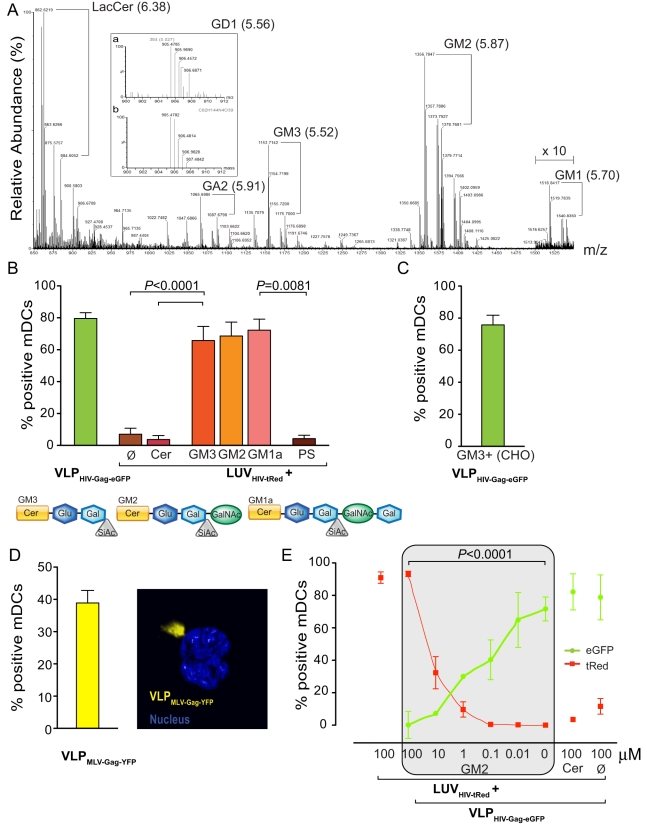
Gangliosides are required for viral capture mediated by mDC.(A) Ganglioside detection in lipid extracts from MT4 derived HIVNL4-3.Partial mass spectrum (from 850 to 1550 amu) corresponding to the 5.3- and 6.5-min range of a UPLC/TOF ESI (+) chromatogram representative of three different viral isolations. The selected time range corresponds to the N-hexadecanoyl (N-C16) species. The N-C22, N-C24, and N-C24:1 species were also observed. For each compound of interest identified, the exact mass of its [M+H]+ and [M+Na]+ ions are indicated. The retention time of each compound is given within parenthesis next to its abbreviation. Inset: exact mass ion cluster obtained at 5.56 min for GD1 (a) and exact mass ion cluster corresponding to the formula C82H144N4O39 with a charge state of 2 (b). X 10 indicates a ten-fold magnification between 1,500 and 1,550 amu. GA2, N-acetyl-D-galactosaminyl-D-galactosyl-D-glucosylceramide; LacCer, D-galactosyl-D-glucosylceramide (lactosylceramide). (B) Comparative mDC capture of VLPHIV-Gag-eGFP produced in HEK-293T and distinct fluorescent LUVHIV-tRed containing Cer, GM3, GM2, GM1a, or PS. A total of 2×105 DCs were pulsed for 4 h at 37°C with 100 µM of LUV or 75 ng of VLPHIV-Gag-eGFP Gag in 0.2 ml, washed with PBS, and assessed by FACS to obtain the percentage of tRed or eGFP-positive cells. Data show mean values and standard error of the mean (SEM) from five independent experiments including cells from at least six donors. mDCs capture significantly higher amounts of GM3-containing LUVHIV-tRed than Cer or Ø LUVHIV-tRed (p<0.0001, paired t test). mDCs capture significantly higher amounts of GM1a-containing LUVHIV-tRed than negatively charged PS-LUVHIV-tRed (p = 0.0081, paired t test). Schematic representation of the gangliosides used in the LUVs for these experiments is shown underneath. (C) Capture of VLPHIV-Gag-eGFP produced in CHO cell line, which is only able to synthesize gangliosides up to GM3. A total of 2×105 mDCs were incubated for 4 h at 37°C with 75 ng of sucrose-pelleted VLPHIV-Gag-eGFP Gag, washed and analyzed by FACS to determine the percentage of eGFP-positive cells. Data show mean values and SEM from one representative experiment out of two including cells from three donors. (D) mDC capture of VLPMLV-Gag-YFP. Graph shows mDCs pulsed for 4 h at 37°C with VLPMLV-Gag-YFP, washed with PBS and assayed by FACS to obtain the percentage of YFP-positive cells. Data show mean values and SEM of cells from three donors. Left image depicts confocal microscopy analysis of pulsed cells, showing a 3-D reconstruction of the x-y sections collected throughout the whole mDC z volume every 0.1 µm. Isosurface representation of DAPI-stained nucleus is depicted, computing the maximum intensity fluorescence of the sac-like compartment surface within a 3-D volumetric x-y-z data field, where VLPMLV-Gag-YFP accumulate within a compartment analogous to that observed for HIV-1. (E) Capture competition between 75 ng of VLPHIV-Gag-eGFP Gag and decreasing amounts (µM) of GM2-containing LUVHIV-tRed. As controls, we used the maximum concentration of LUVHIV-tRed (100 µM) with or without Cer. Cells were incubated for 4 h at 37°C, washed and analyzed by FACS to establish the percentage of eGFP- and tRed-positive cells. Data show mean values and SEM from three independent experiments including cells from at least four donors. mDCs capture fewer VLPHIV-Gag-eGFP in the presence of higher amounts of GM2-containing LUVHIV-tRed (p<0.0001, paired t test).